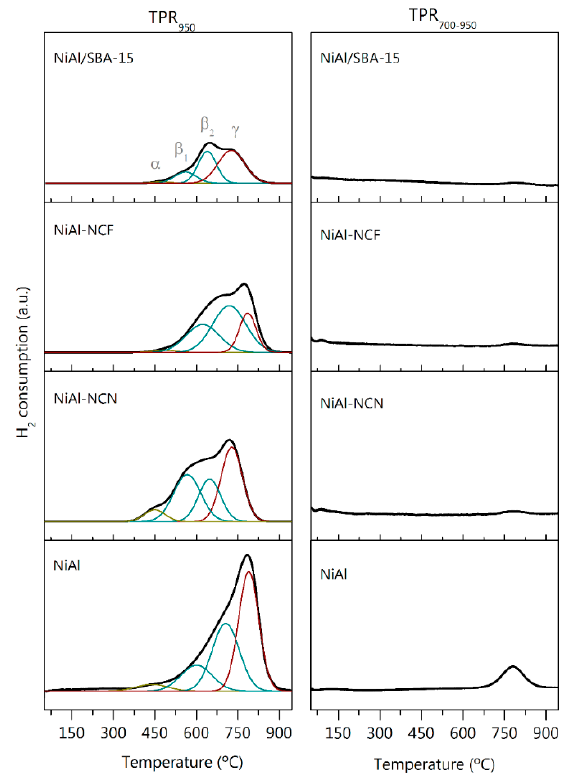
Figure 5. H 2 -TPR profiles of NiAl/SBA-15 and nanocasted solids. TPR 950 : reduction profile of Figure 5. H 2 ‐ TPR profiles of NiAl/SBA ‐ 15 and nanocasted solids. TPR 950 : reduction profile of cal ‐ cined solids; TPR 700 ‐ 950 : reduction profile of fresh reduced catalyst. calcined solids; TPR 700–950 : reduction profile of fresh reduced